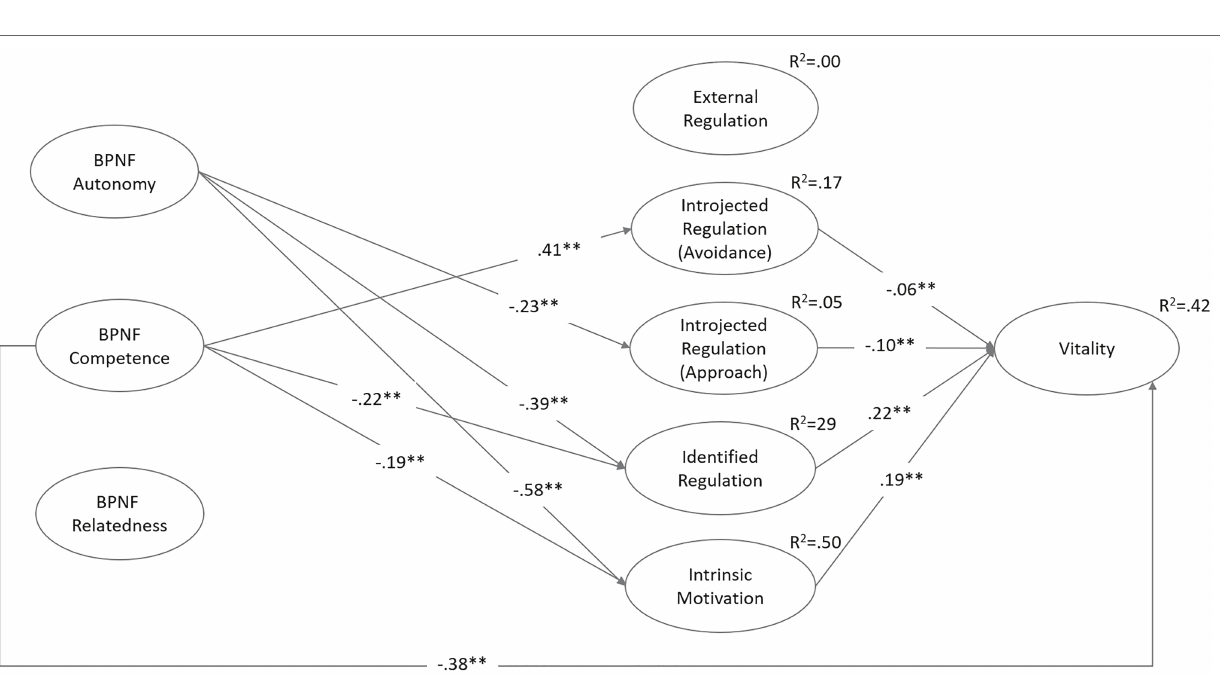
FIGURE 2 | Structural equation model with BPN-Frustration, motivational regulation and vitality (during the forced distance learning period). χ 2 (494) = 1626.855, p < 0.01, CFI = 0.965, RMSEA = 0.027. Variables are modelled latently; measurement models are not shown; * p < 0.05, ** p < 0.01; non-significant paths are not shown.